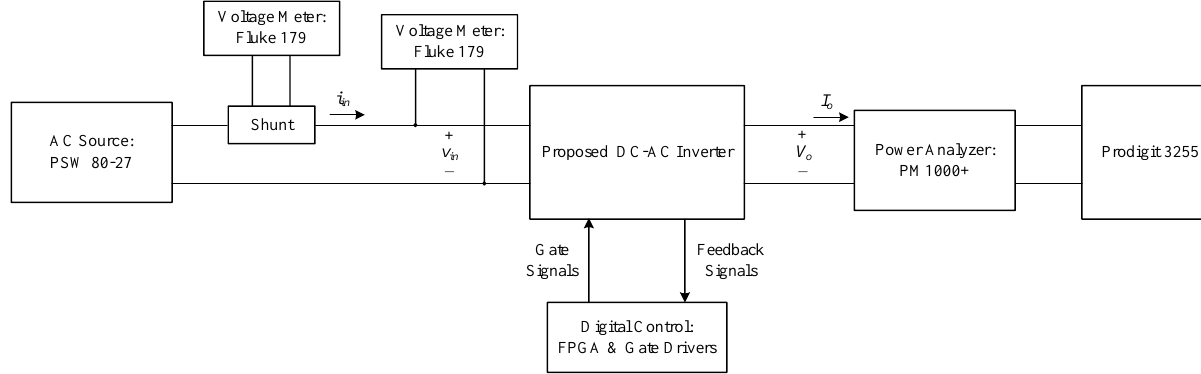
Figure 24. Efficiency measurement block diagram.